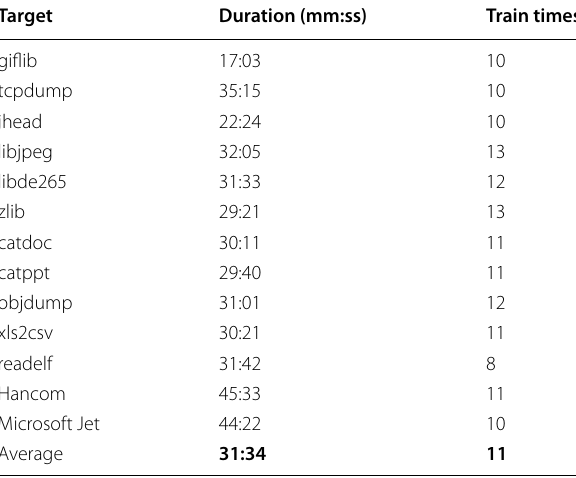
Table 7 GPU time during 24 h testing Target